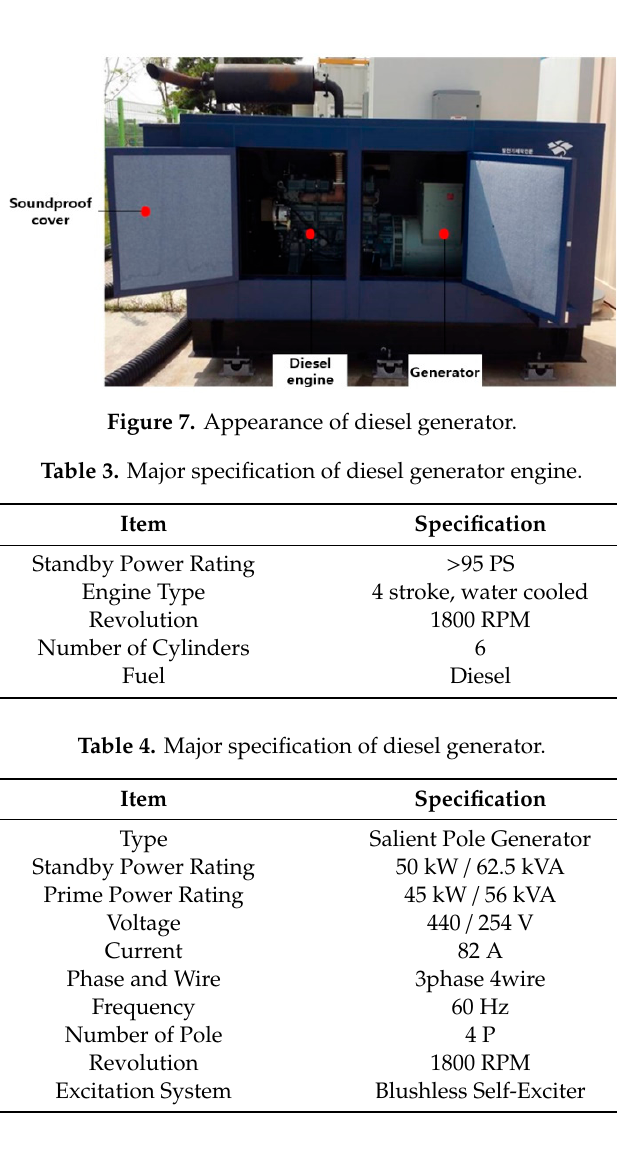
Table 5. Specification of the load bank.